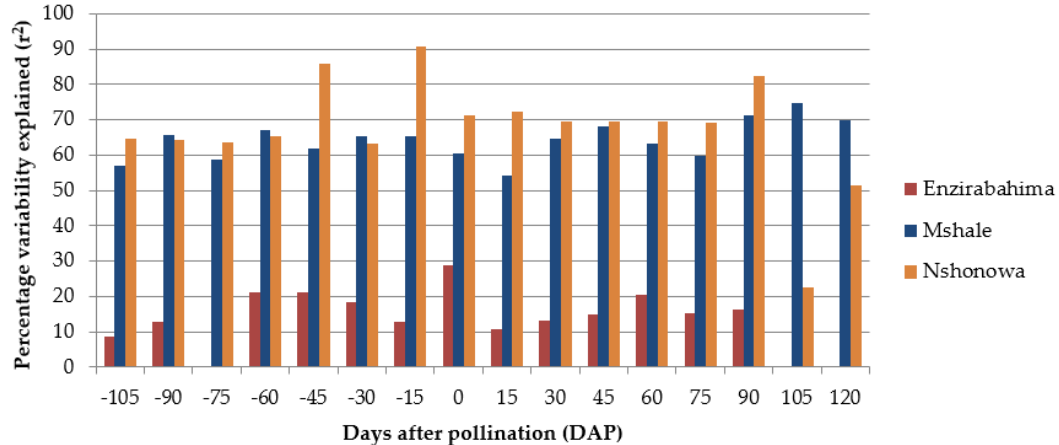
Figure 1. Percentage variability (r 2 ) explained by the multiple linear model of seed set per 100 fruits as the dependent variable and weather attributes as independent variable at different development time intervals in ‘Enzirabahima’, ‘Mshale’ and ‘Nshonowa’ after pollination with ‘Calcutta 4 ′ between January 2016 and January 2019.